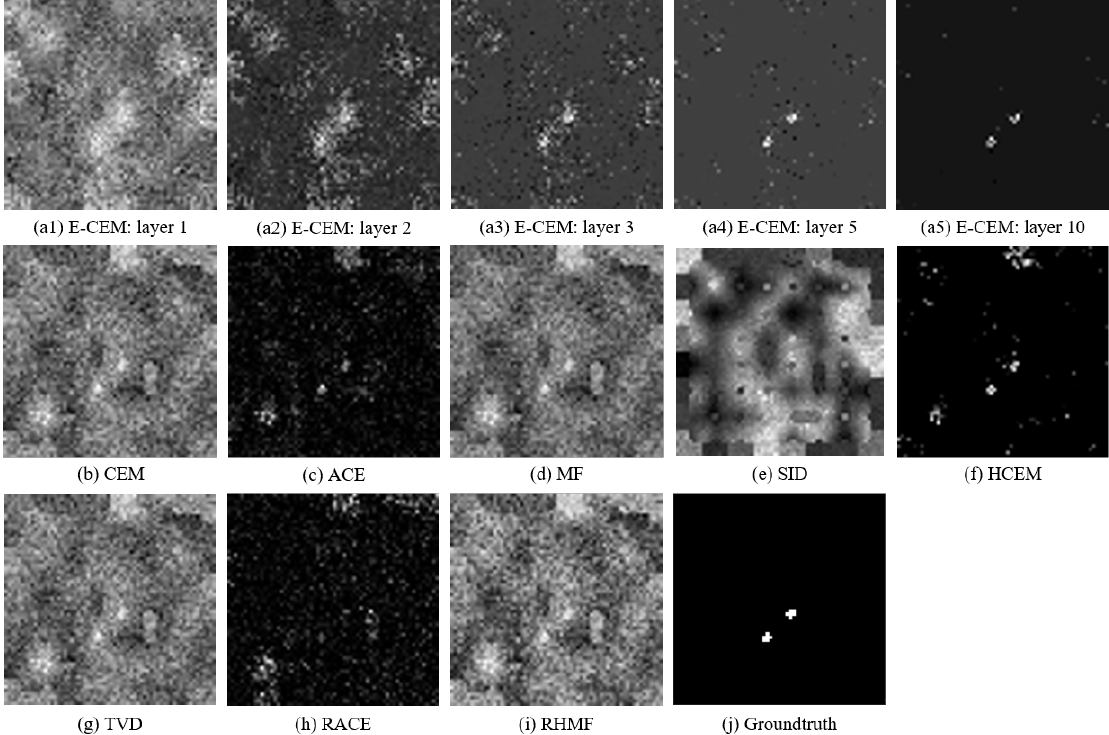
Figure 6. Detection outputs of different algorithms on the synthetic data (with noise of 20 dB SNR): First row ( a1 – a5 ): 1st, 2nd, 3rd, 5th and 10th layer of the E-CEM’s outputs. Second row and third row ( b – i ): results of CEM [2], ACE [10], MF [11], SID [9], HCEM [17], TVD [15], RACE [37], RHMF [16] and the proposed E-CEM. ( j ): ground truth. All outputs are normalized to [ 0,1 ]